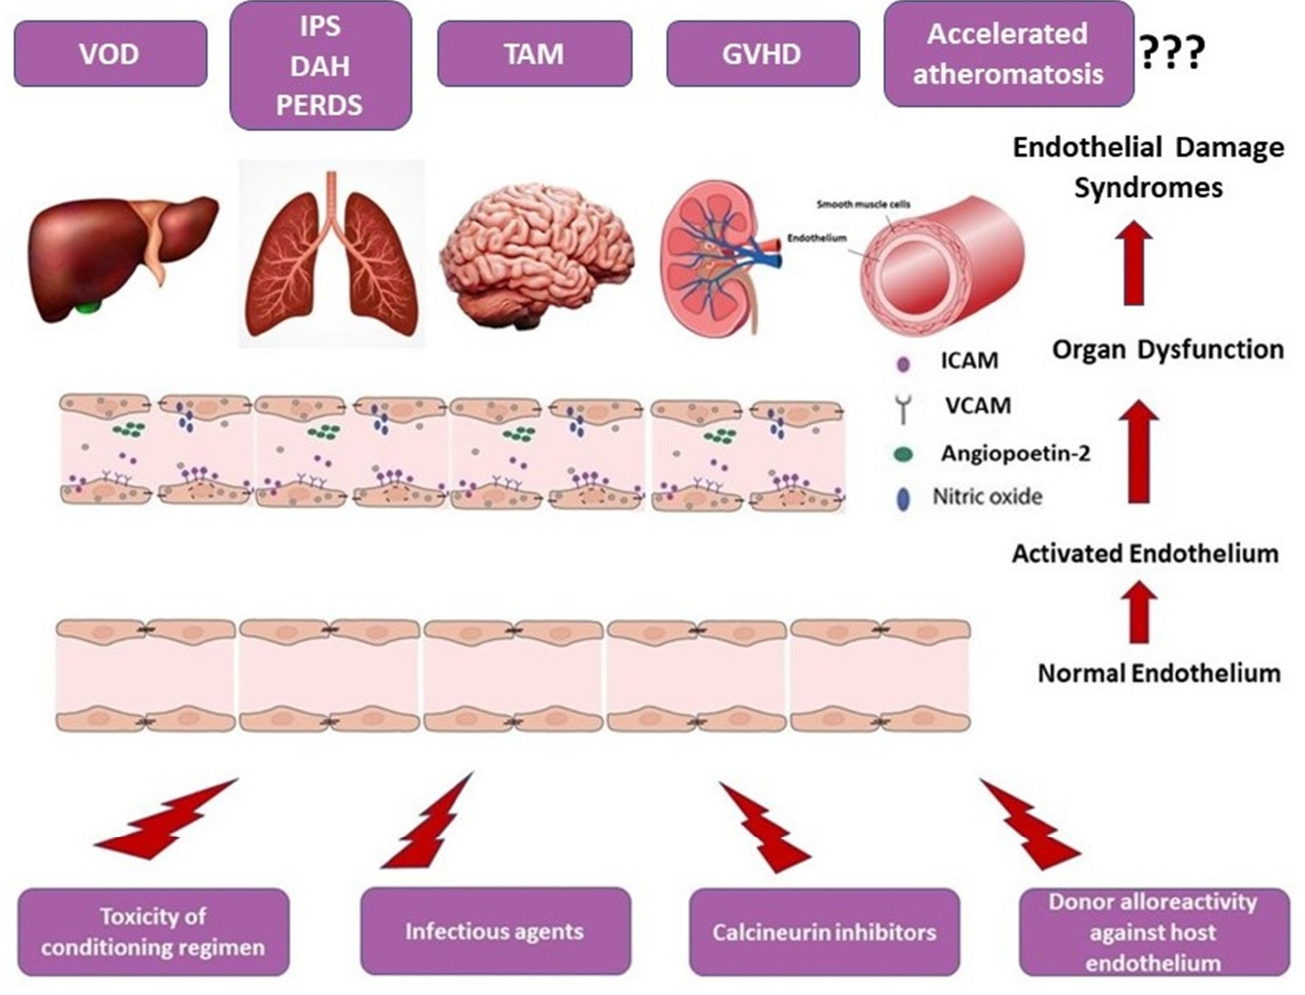
Figure 2. Pathogenesis of endothelial dysfunction syndromes.